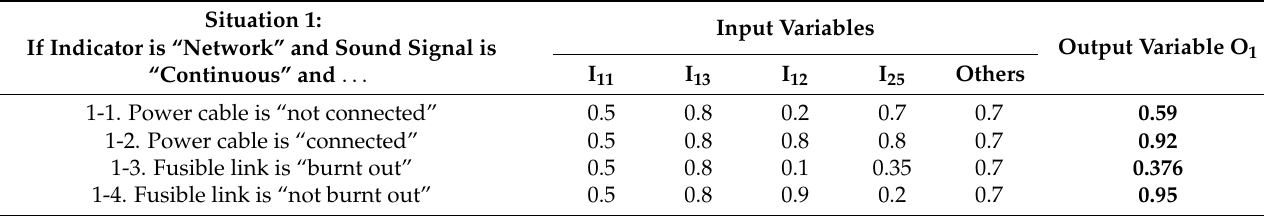
Table 4. Modeling results on Situation 1.